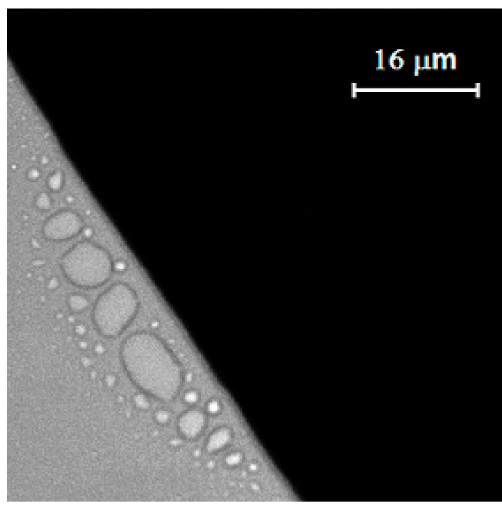
Figure 4. Separation of surfactant from the base liquid at the vicinity of the silver nanofluid triple line was observed on a glass substrate by microscope.